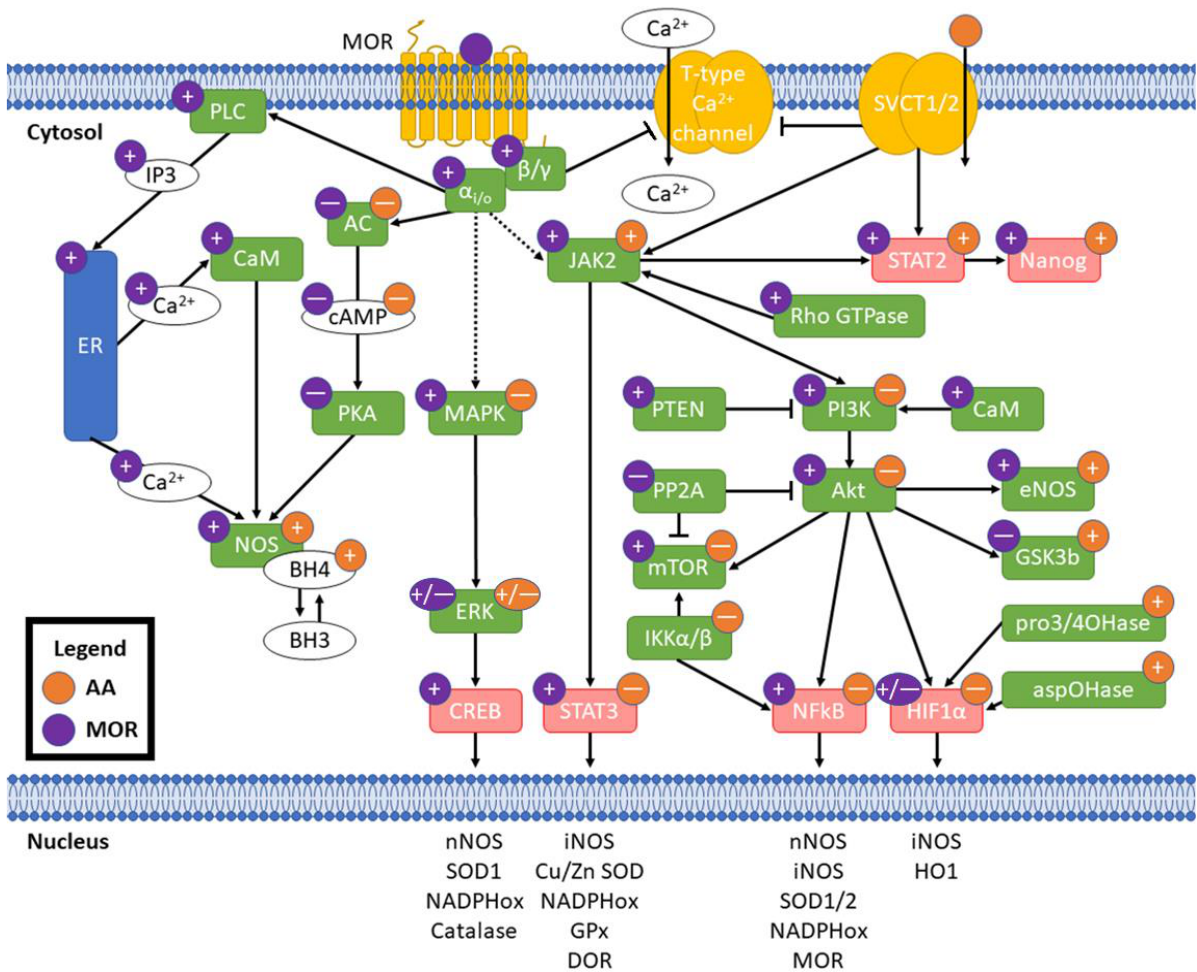
Figure 3. Potential crosstalk between MOR activation and AA. Purple circles indicate effect of MOR activation and orange circles indicate effect of AA; “+” is an increase, “—” is a decrease, and “+/—” indicates mixed effects from literature. Pointed arrowheads indicate activation and flat arrowheads indicate decreased activity. Solid arrows indicate direct effects and dashed arrows indicate indi- rect/distal effects. Green boxes are enzymes and red are transcription factors. Transcription of example redox genes and proteins listed in the nucleus is affected by their linked transcription factors.